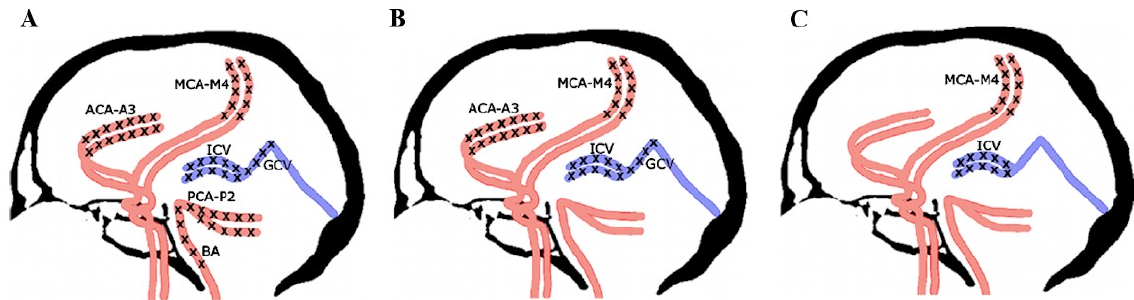
Figure 1. Various scales used for CCA diagnosis in CTA imaging: ( A ) 10-point scale, where positive result (score = 10) confirming CCA is stated when bilateral ACA-A3, MCA-M4, PCA-P2 and ICV and single GCV and BA are not opacified; ( B ) 7-point scale, where positive result (score = 7) confirming CCA is stated when bilateral ACA-A3, MCA-M4 and ICV and single GCV are not opacified; ( C ) 4-point scale, where positive result (score = 4) confirming CCA is stated when bilateral MCA-M4 and ICV are not opacified.